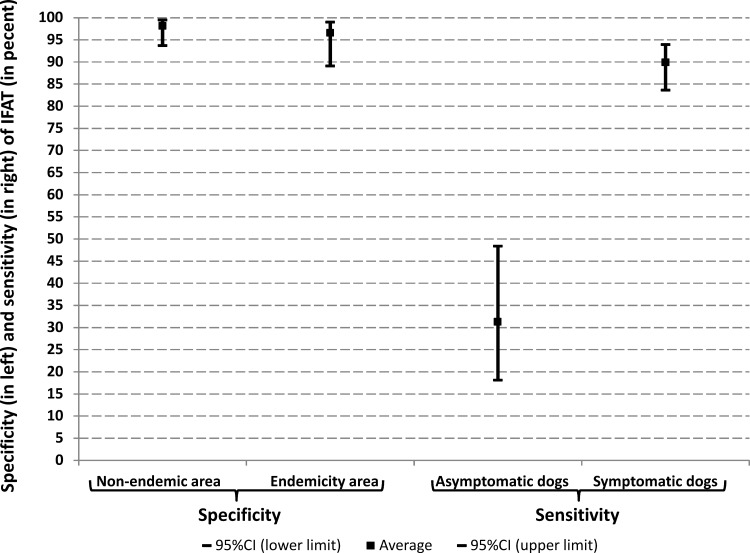
Estimated sensitivity and specificity of IFAT based on the systematic review and meta-analysis (based on available studies from classical validation method).The specificity was estimated in non-endemic and endemic area. The sensitivity was estimated in asymptomatic and symptomatic dogs in endemic Mediterranean basin. The sensitivity of the IFAT in endemic areas was estimated using a sum of 103 asymptomatic dogs (32 of them were positive in IFAT) and using a sum of 173 symptomatic dogs (161 of them were positive in IFAT). The corresponding numbers of Se studies for asymptomatic and symptomatic dogs were [22, 50, 53, 60, 81] and [22, 28, 50, 52, 53, 54, 60, 81] respectively. The corresponding numbers of Sp studies for non-endemic and endemic area were [53, 54, 60, 76] and [48, 54, 55, 57, 58, 59, 76, 80] respectively (see S1 Table). Heterogeneity tests were significant (p = 0.01 and p<0.001, for the Se, and the Sp respectively).